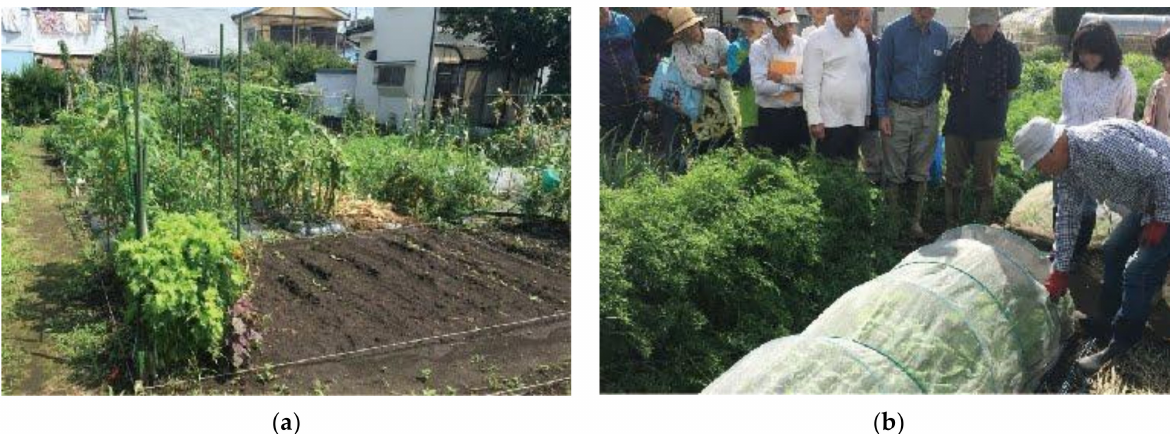
Figure 2. An allotment and an experience farm: ( a ) Midori-machi allotment, Hachioji City and ( b ) Tommy Club (experience farm), Nishi-Tokyo City. (Photographs: Kentaro